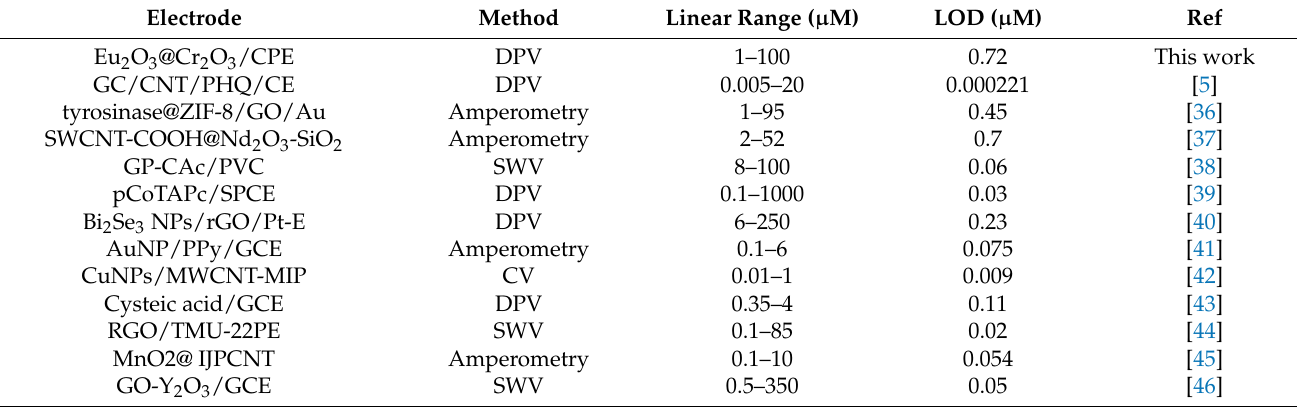
Table 1. Comparison of the recently reported literature for L-DOPA sensors.